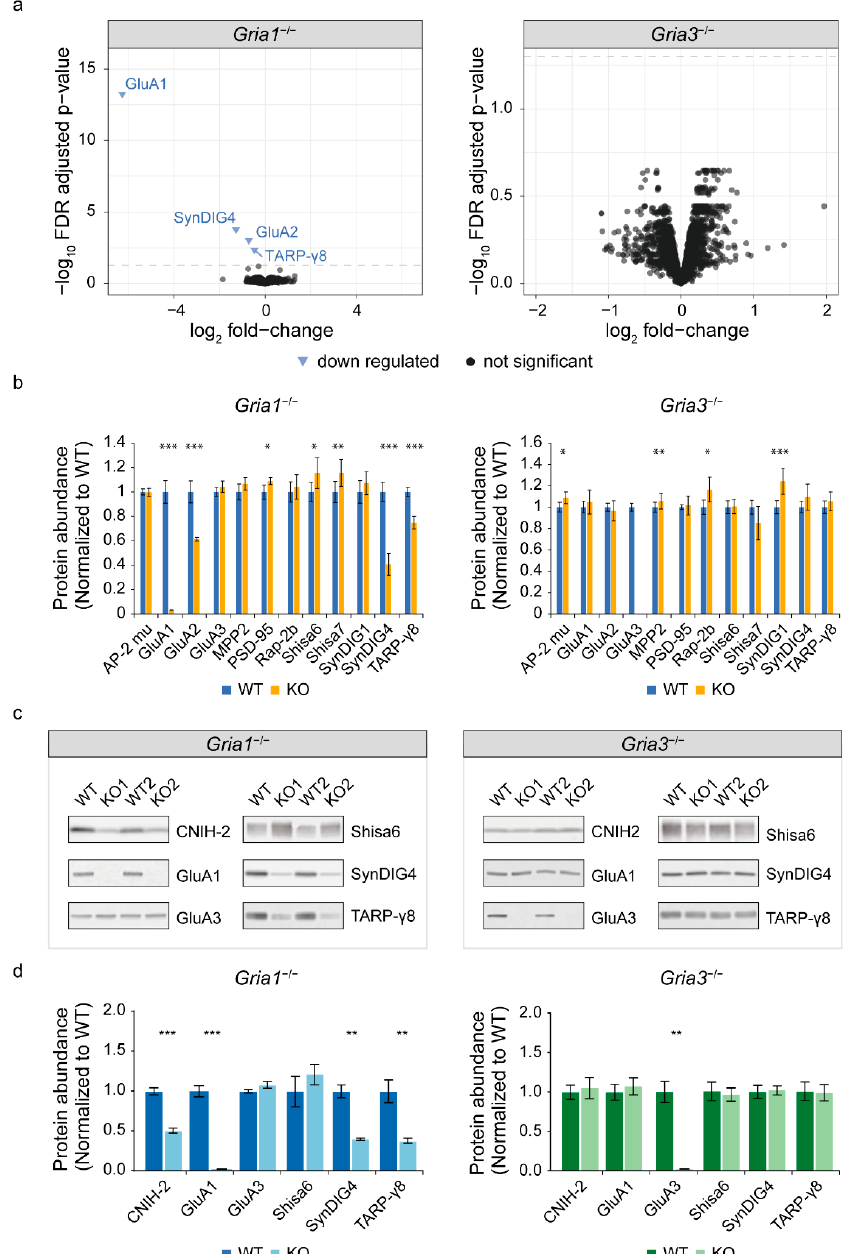
Figure 1. Expression proteomics of Gria1 and Gria3 KO synapse enriched fractions. ( a ) Differential abundance analysis revealed 4 proteins with reduced protein expression in Gria1 KO mice ( left ) (n = 6/condition). No overall changes were observed in Gria3 KO animals ( right ) (n = 6 WTs, n = 5 KOs). The dotted lines show the eBayes false discovery rate (FDR)-adjusted p -value cut-off (5% FDR). ( b ) Selective mass spectrometry data analysis of known AMPA glutamate receptor (AMPAR) interactors revealed specific differential regulation of interactors in Gria1 KO (n = 6/condition) or Gria3 KO mice (n = 6 WTs, n = 5 KOs) (eBayes, non-FDR-adjusted p -value cut-off < 0.05). AP-2 complex subunit mu is here abbreviated as AP-2 mu. ( c ) Immunoblot validation of mass spectrometry data. ( d ) Quantification of immunoblot validation (n = 6/condition). WT: wildtype; KO: knock- out. Mass spectrometry and immunoblot quantification bar graphs show mean protein abundances normalized to wildtypes ± s.e.m. * p -value < 0.05, ** p -value < 0.01, *** p -value < 0.001, all are non-FDR-adjusted (see supplemental Tables S1 and S2 for details on